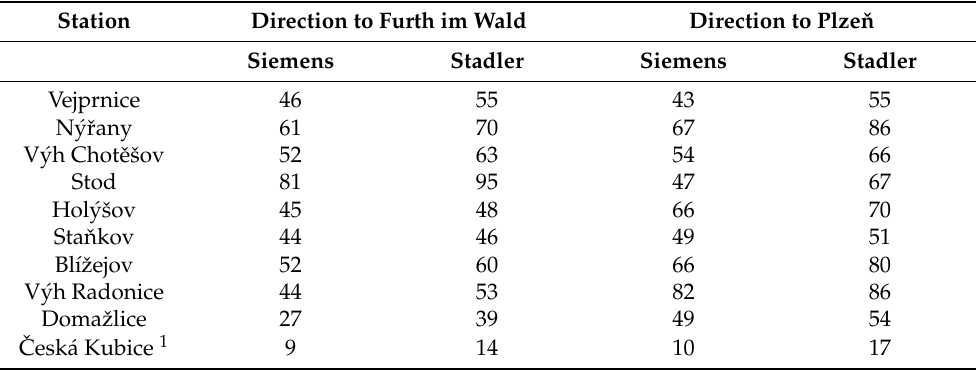
Table 6. Traction energy consumption [kWh] of stops in intermediate stations on the line 180. Source: